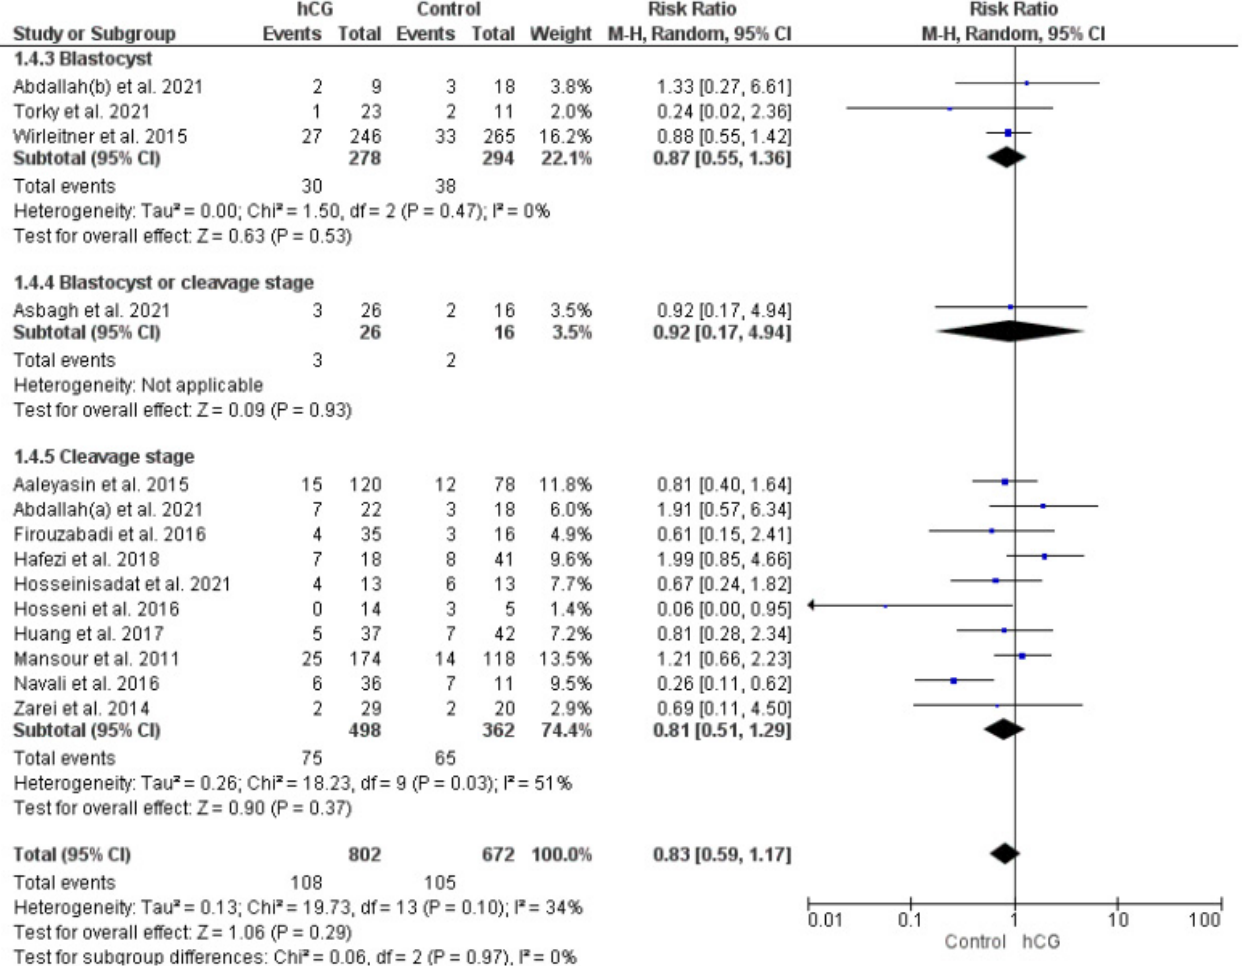
Figure 3. Forest plot showing the effect of intrauterine hCG injection versus control group on miscarriage rate.